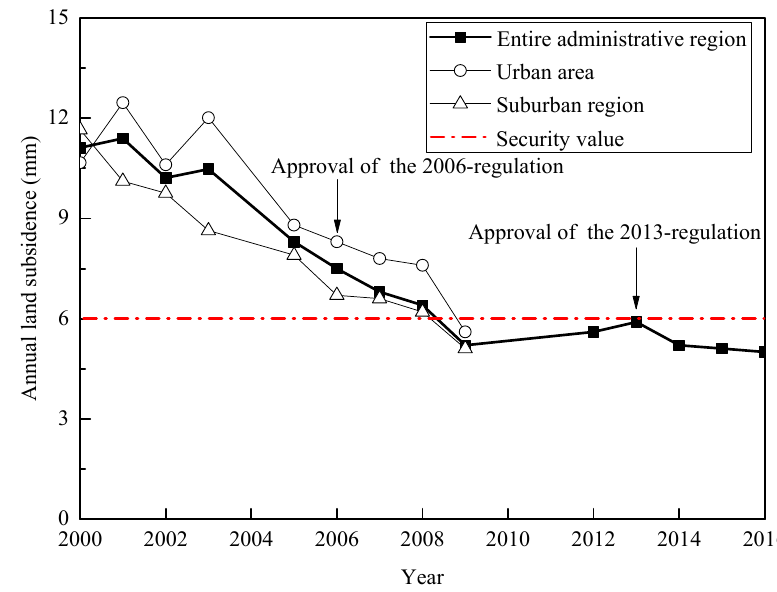
Figure 8. Monitoring results of annual land subsidence between 2000 and 2016 in Shanghai (data from Reference [26]).